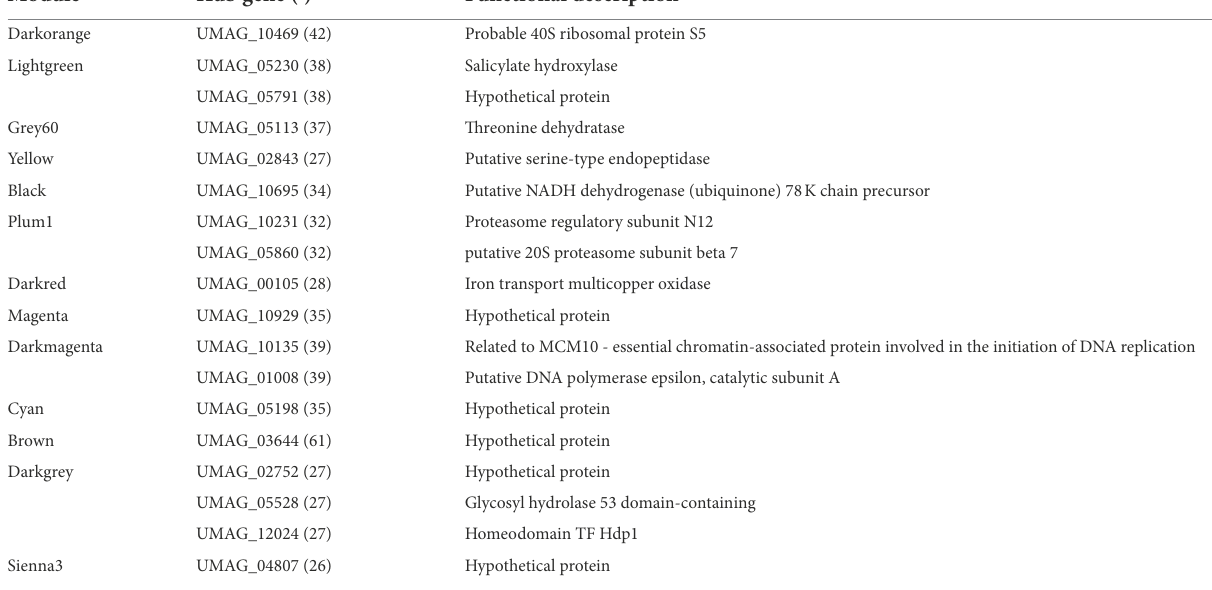
TABLE 2 Hub genes and their encoding proteins in the GCN modules of U. maydis .